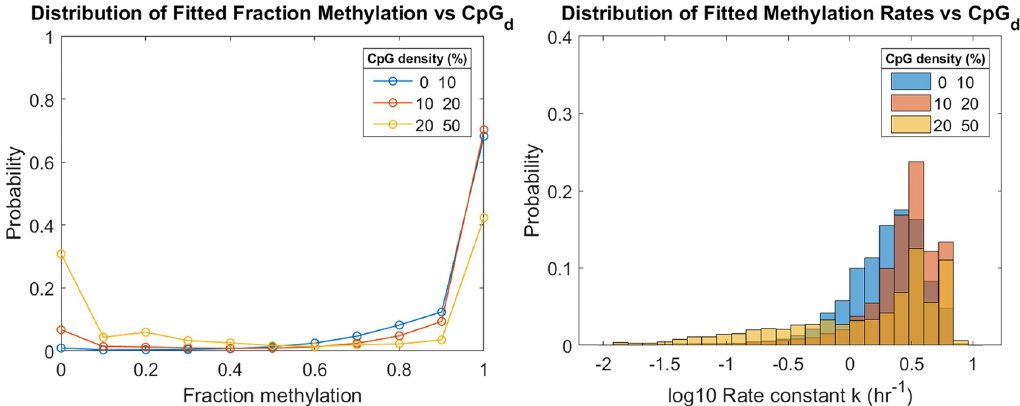
Fig 6. Remethylation rates and fraction methylation distributions for low, medium, and high-density CpG sites of Chr1. CpG density (CpG d ) of a site i is determined as the fraction of bp that are part of a CpG dinucleotide within a radius of 50 bp upstream and downstream the DNA molecule. Low-density CpG-sites represent 87% of the total sites analyzed in Chr1. Medium-density CpG sites represent a 12%, and high-density sites less than 1%. Low density is defined as [0,10)%. Medium density is defined as [10,20)%. High density is defined as [20, CpG (50%).